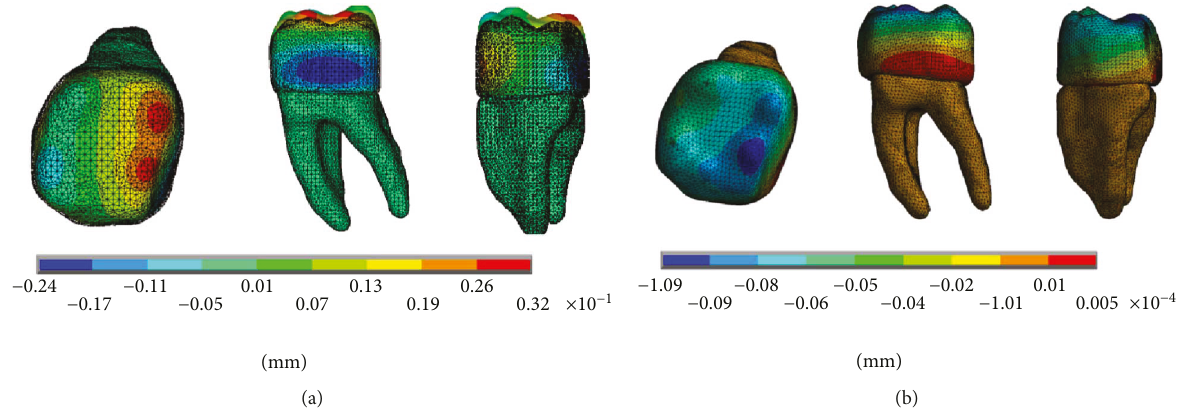
Figure 16: Displacements in the x -axis. (a) Noncontact. (b) Contact.